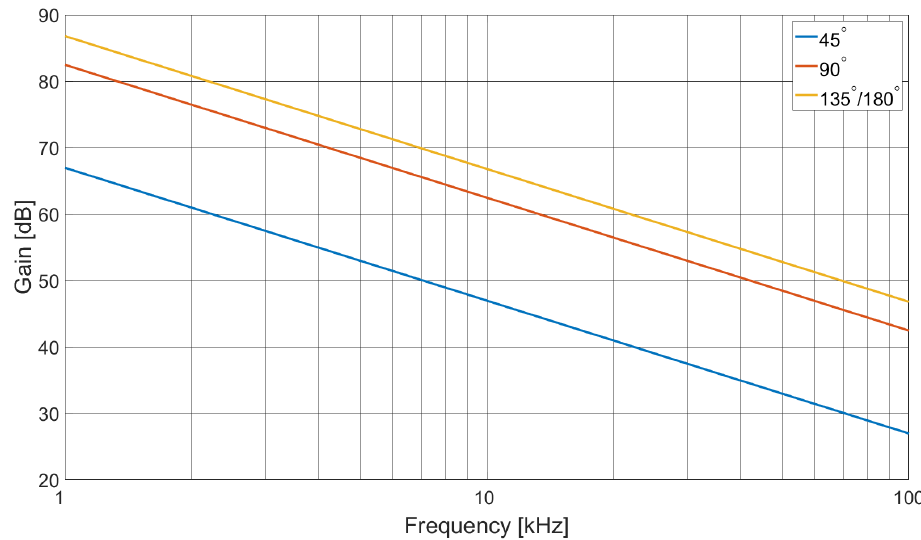
Figure 3. Graph showing required system gain as a function of frequency for different coil pair